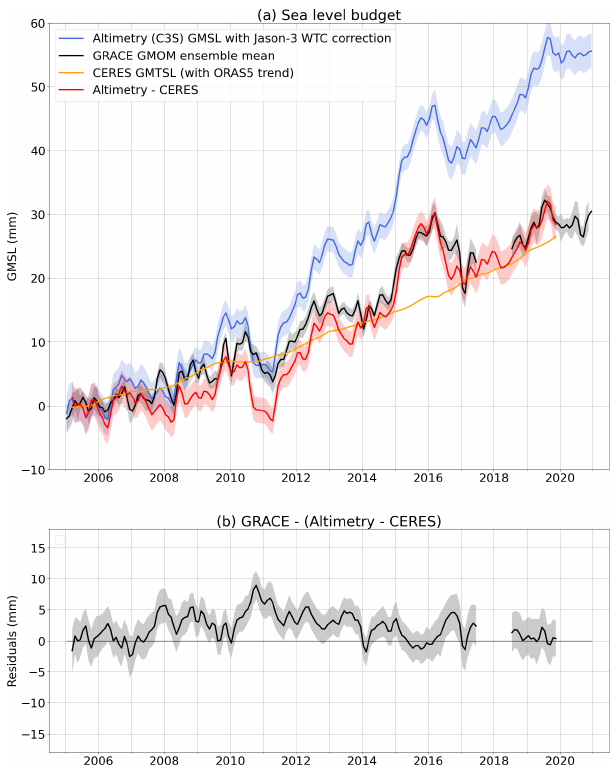
Figure 8. Sea level budget. (a) Budget with GRACE/GRACE-FO- based global mean ocean mass (GMOM) variations compared to altimetry-based GMSL (corrected for the Jason-3 radiometer WTC drift) and ORAS5 GMTSL. (b) Budget residuals. Linear trends of all components over different periods of time are provided in Ta- ble S1.